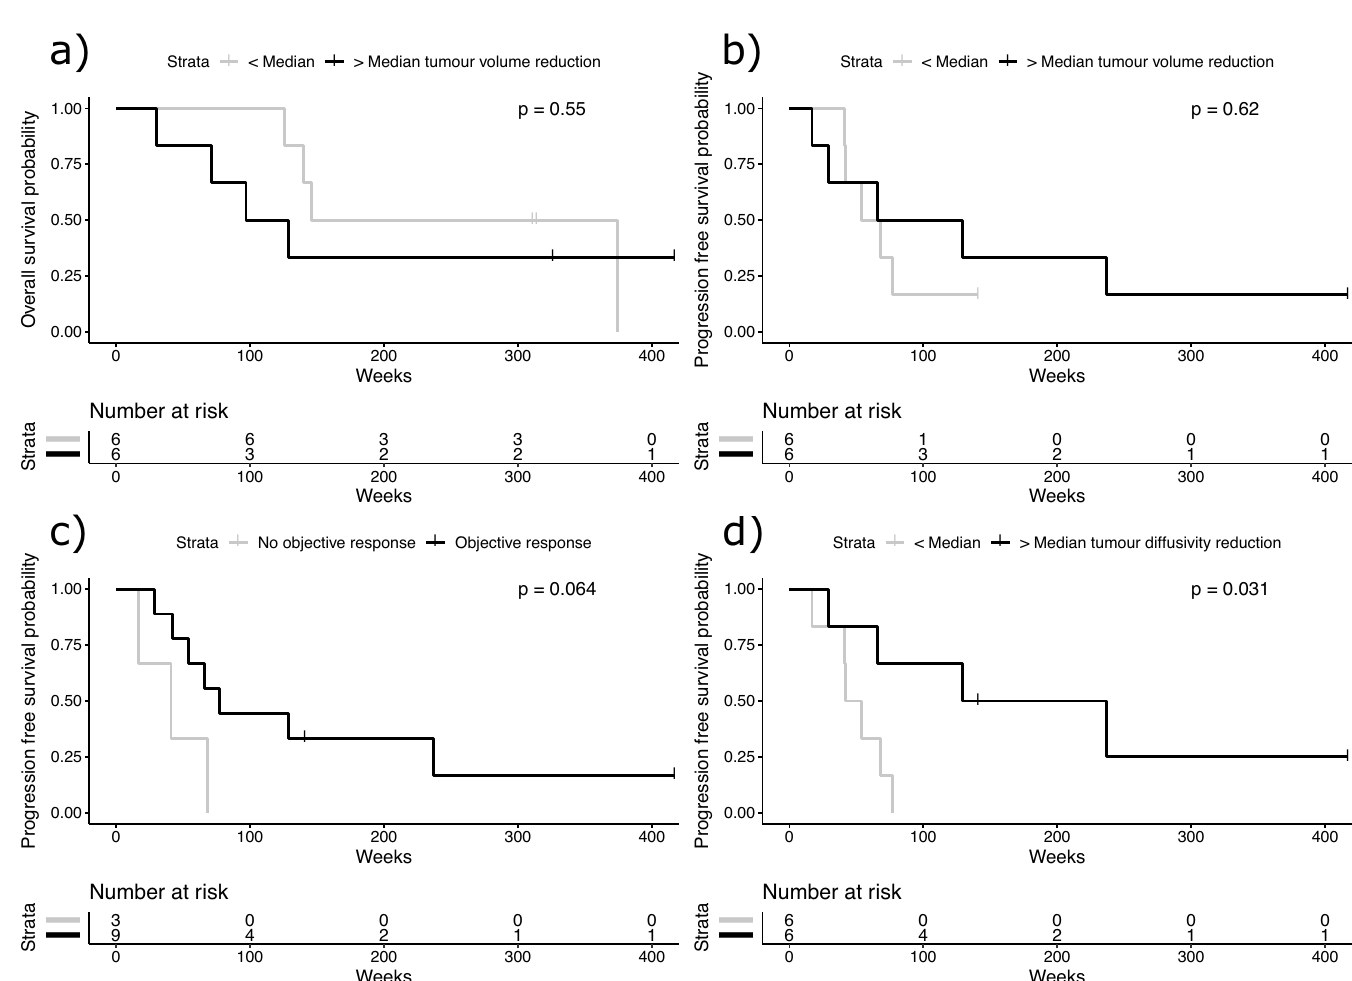
Fig 2. Kaplan Meier survival curves showing no overall survival benefit for participants with larger than median relative tumour volume reduction following 12 days of pre-surgical sunitinib therapy, however, there was a trend for participants with less volume reduction to survive longer (a). No difference in PFS was observed (b) Participants with a larger reduction in tumour diffusivity D experienced longer PFS (c) while there was a trend for participants with objective response according to RECIST 1.1 (partial or complete response) to show longer PFS than patients without objective response (stable or progressive disease) (d). P-values for log-rank test.